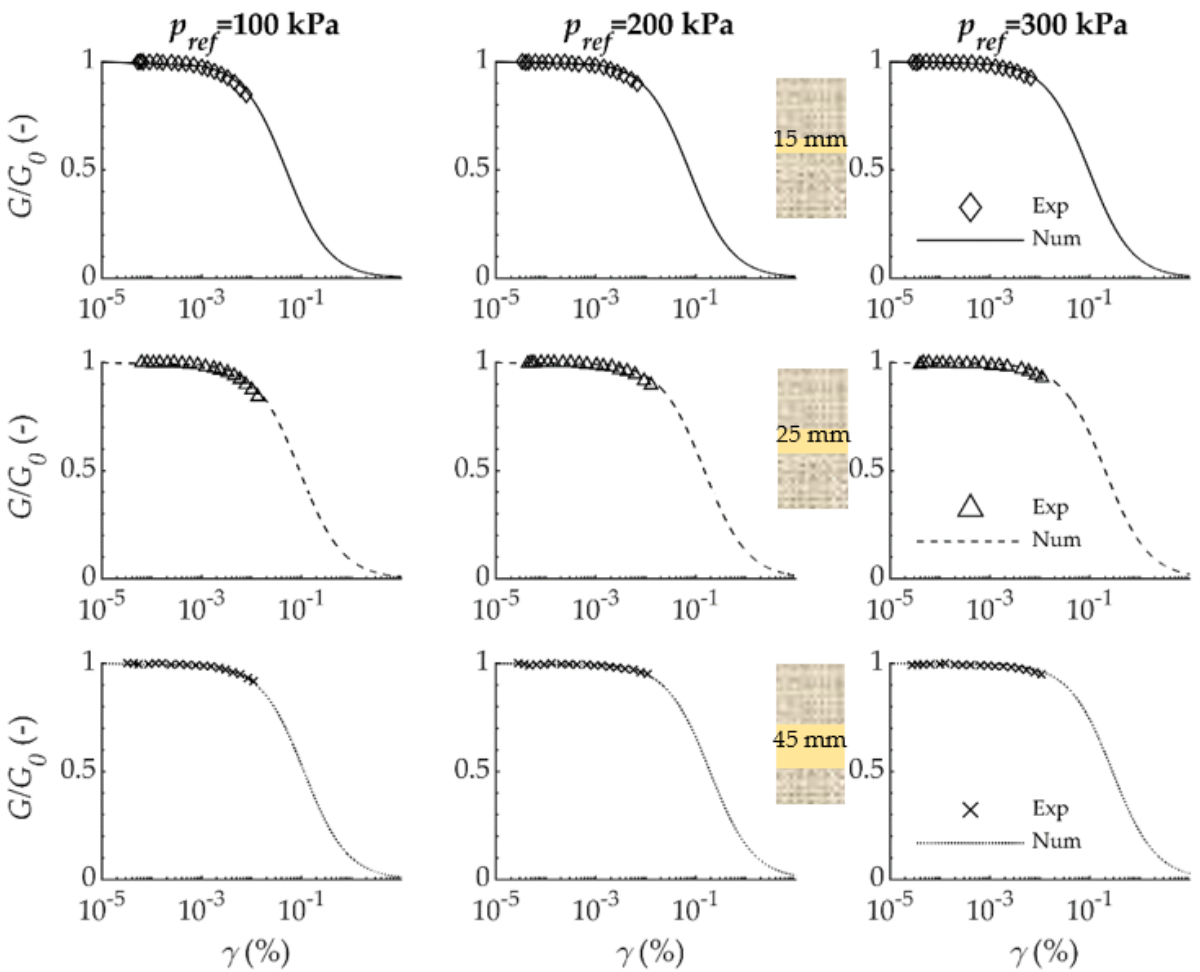
Figure 6. Numerical (Num) vs. experimental (Exp) comparison of the shear modulus decay for composite sand– polyurethane samples at three thicknesses (15, 25 and 45 mm) and for three confining pressures.